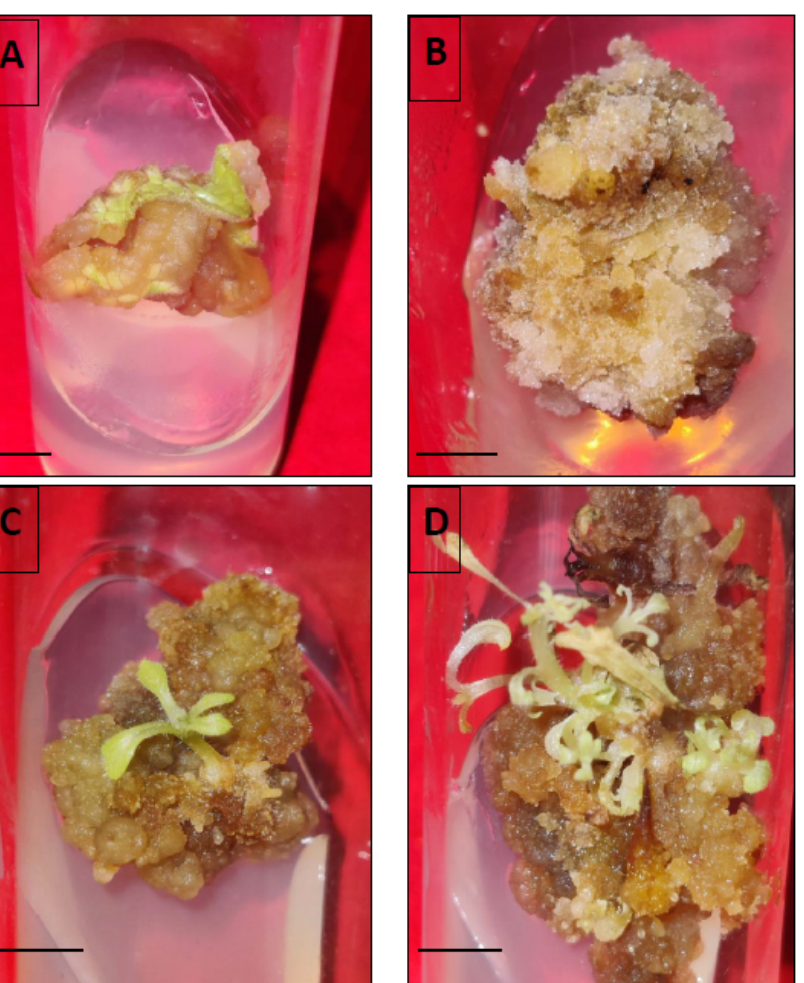
Figure 2. Callus induction and callus-mediated shoot organogenesis from leaf explant in D. purpurea . ( A ) Callus initiation (bar = 1.0 cm), ( B ) Callus proliferation after postweeks (bar = 0.5 cm), ( C , D ) Shoot regeneration from leaf derived callus (bars = 0.5 cm). Table 3. Effect of different concentrations as well as combinations of PGRs on somatic embryogenesis from hypocotyl callus in D. purpurea .